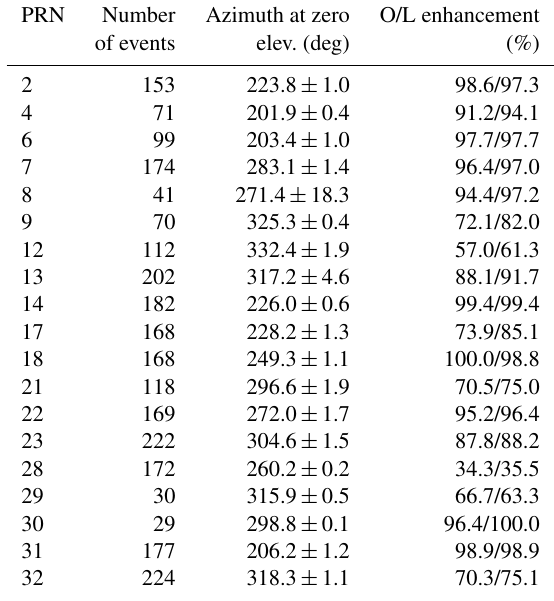
Table 1. Number of low-elevation events and azimuth angle at zero elevation for all 19 PRNs recorded during 311 days in 2014. Az- imuth angle is given as mean and 1 σ standard deviation. The last column lists the percentages of observation in which O/L tracking reached a lower elevation angle than the corresponding C/L detec- tion. The first number refers to O/L channel A, the second to chan- nel